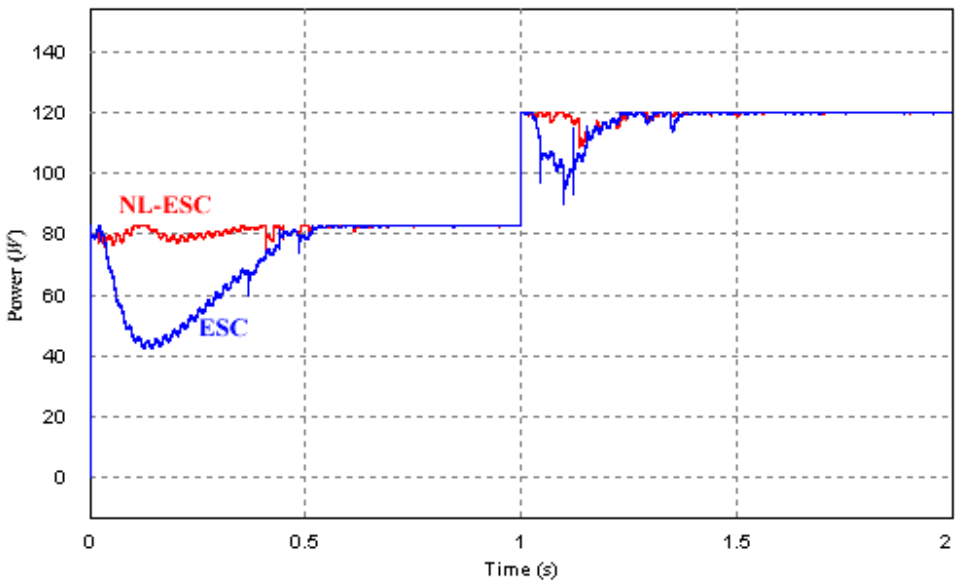
Figure 16. Transient of panel power in front an abrupt irradiance decrease in NL-ESC case ( Red ) and in ESC case ( Blue